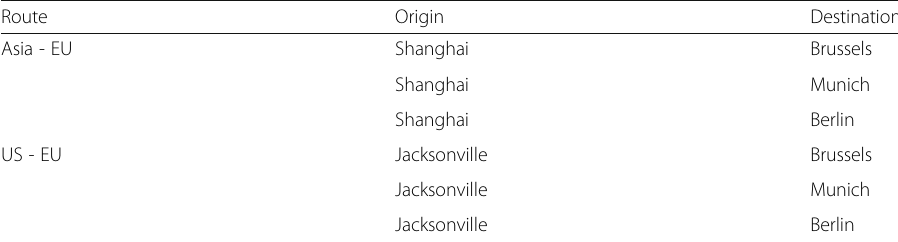
Table 13 Considered supply chains Route Origin